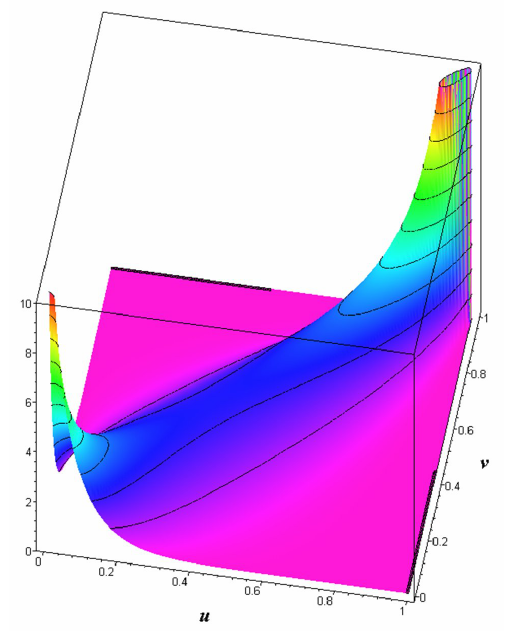
Figure 10: Symmetric Gamma copula density c Γ